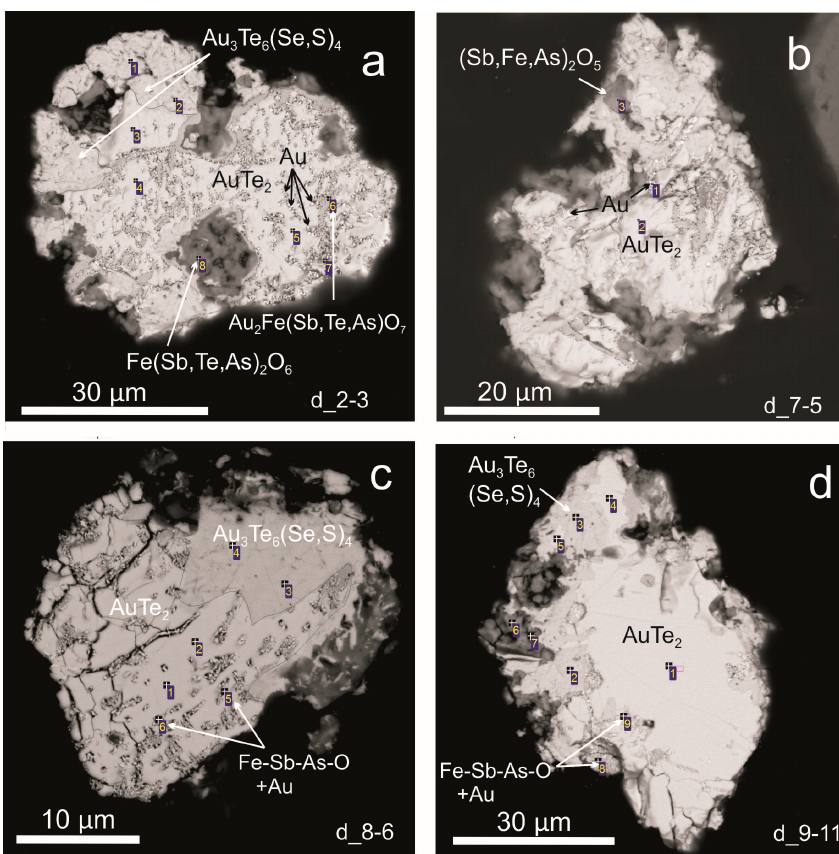
Figure 7. SEM images showing the reacted calaverite grains, the surface of microporous gold ( a – d ), and boundary between microporous gold and calaverite ( a – d ). AuTe 2 —calaverite, Au 3 Te 6 (Se,S) 4 — maletoyvayamite, and Fe(Sb,Te,As) 2 O 6 —tripuhyite. 1–9—the compositions of compounds